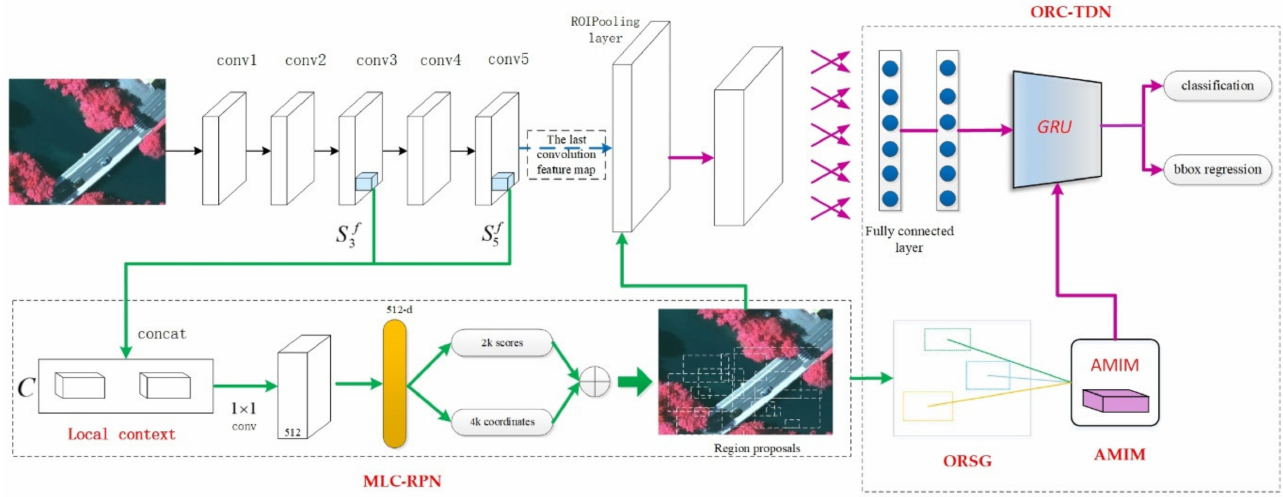
Figure 2. The overall framework of diversified context information fusion framework based on convolutional neural network